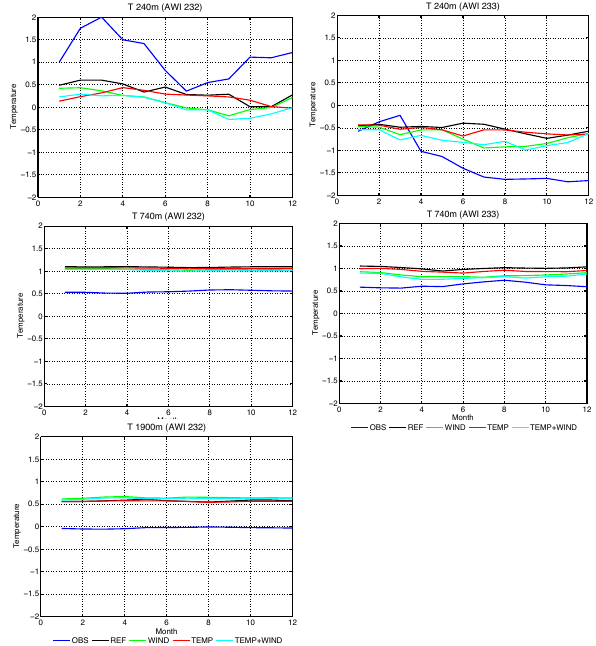
Fig. 10. Comparison of the mean temperature at the AWI 233 and 232 moorings (see Figs. 7 and 8 for position) simulated for each month and averaged over the period 1985–1989 (black line for REF, green line for WIND, red line for TEMP and cyan line for WIND + TEMP) with observations over the period 1996–2000 (blue